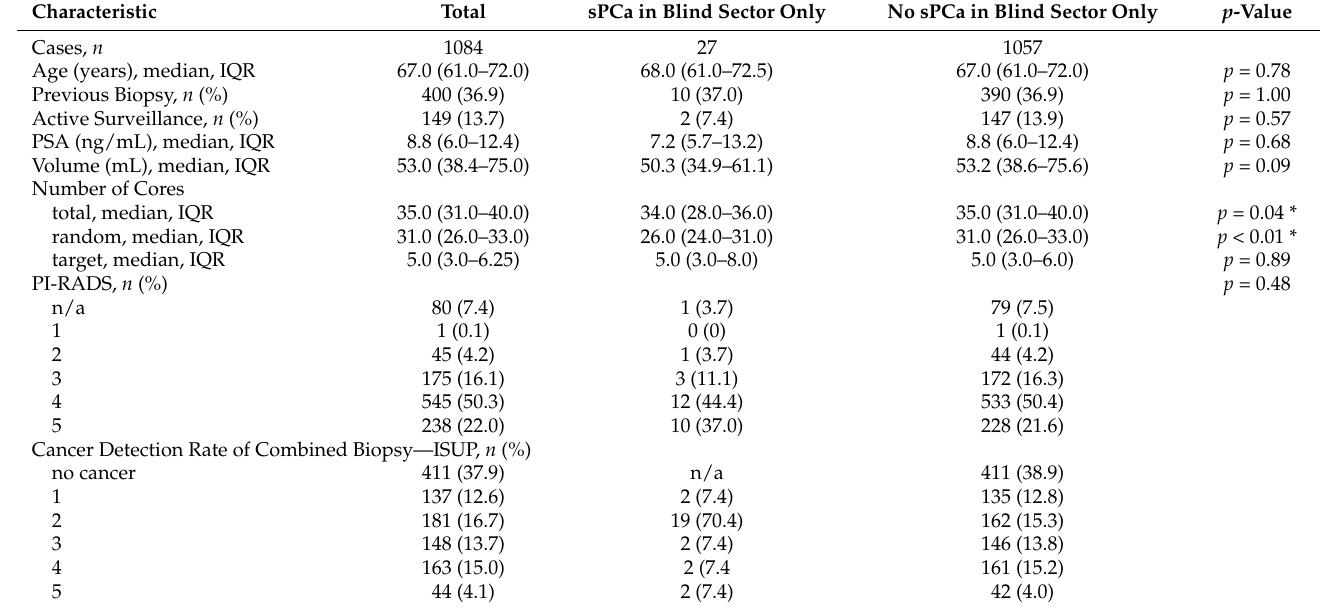
Table 1. Patient characteristics between the group with sPCa within blind sector only and no sPCa within blind sector only.